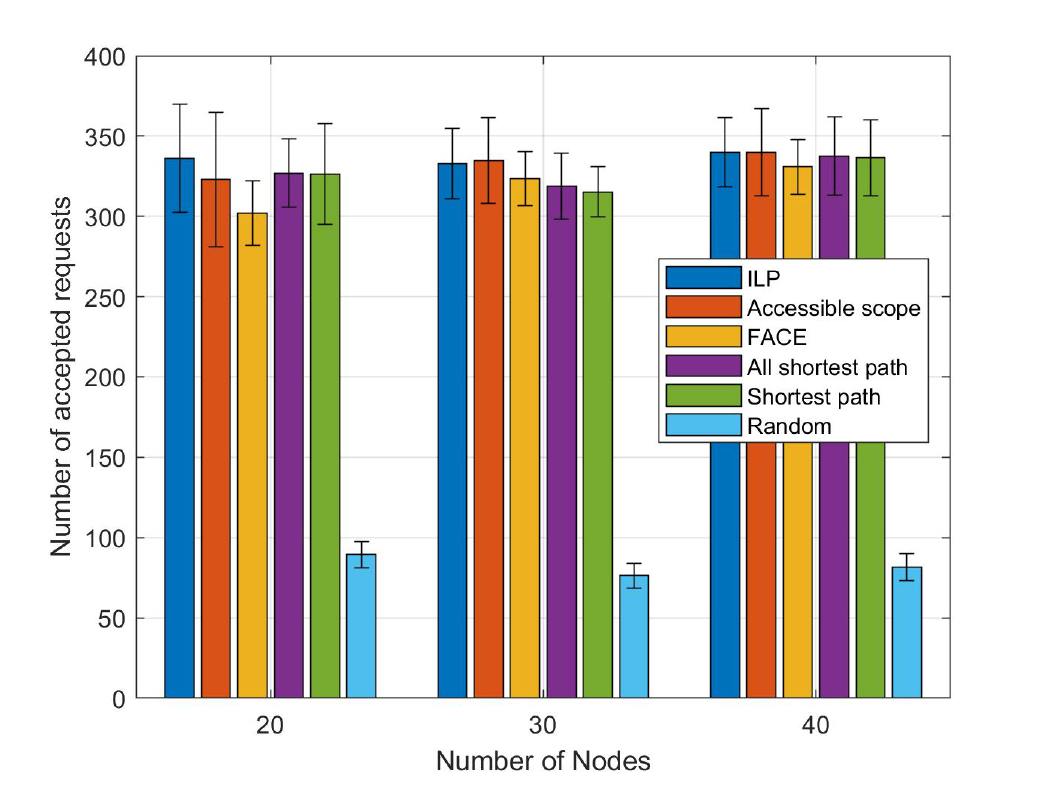
Figure 6. Average number of accepted